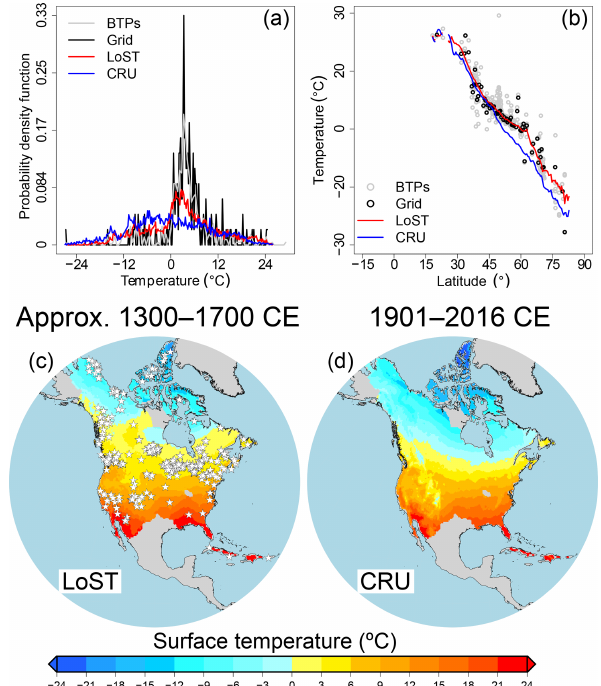
Figure 2. Histogram (a) and latitudinal mean temperatures (b) from BTP measurements (gray), LoST temperatures at grid cells contain- ing BTP measurements (black), LoST temperatures (red) and mean surface air temperature from the CRU database (blue). LoST tem- peratures ( ∼ 1300–1700CE) (c) compared with the mean surface air temperature from CRU data (1901–2015CE) (d) . White stars in (c) indicate the locations of the 514 BTP